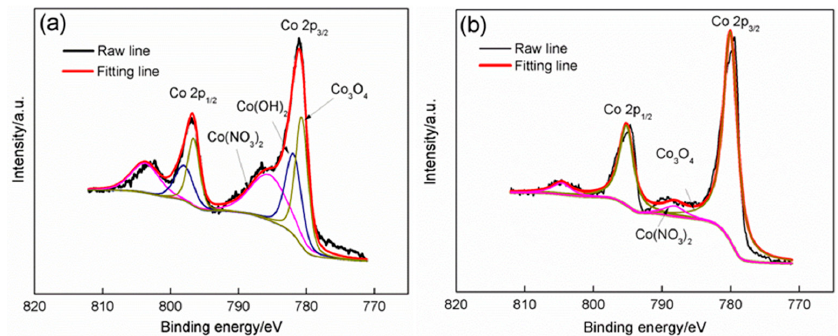
Figure 7. High resolution XPS spectra of Co 2p in sample D: ( a ) before annealing; ( b ) after annealing.